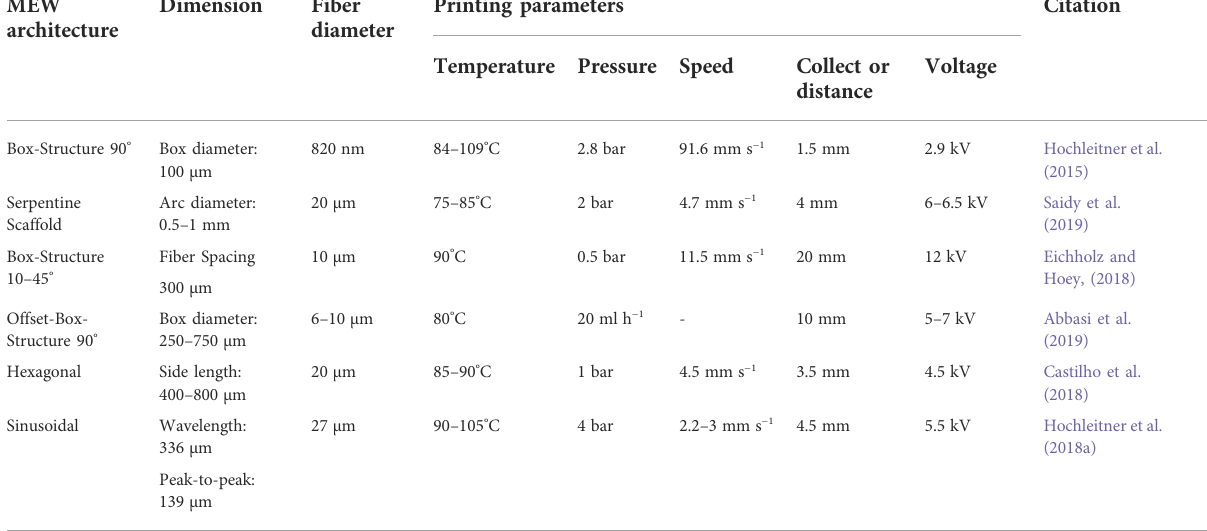
TABLE 2 MEW structural design overview: Different scaffold architectures fabricated with MEW. Indicated are die dimension of building blocks, the fi berdiameterandtheprocessingtemperature(in ° C),thevoltage(inkV),thedistancebetweencollectorandnozzle(inmm),theprintingspeed(in mm s − 1 ) and the material fl ow (in ml min − 1 or